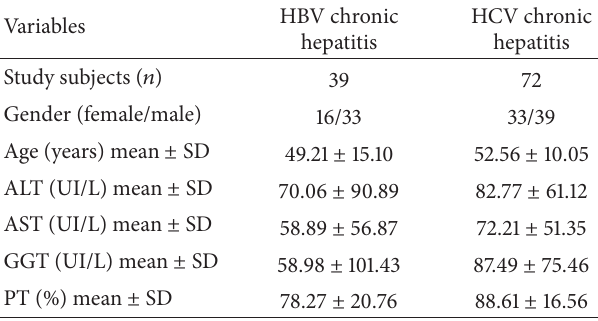
Table 1: Clinical and laboratory information about the HBV and HCV infected